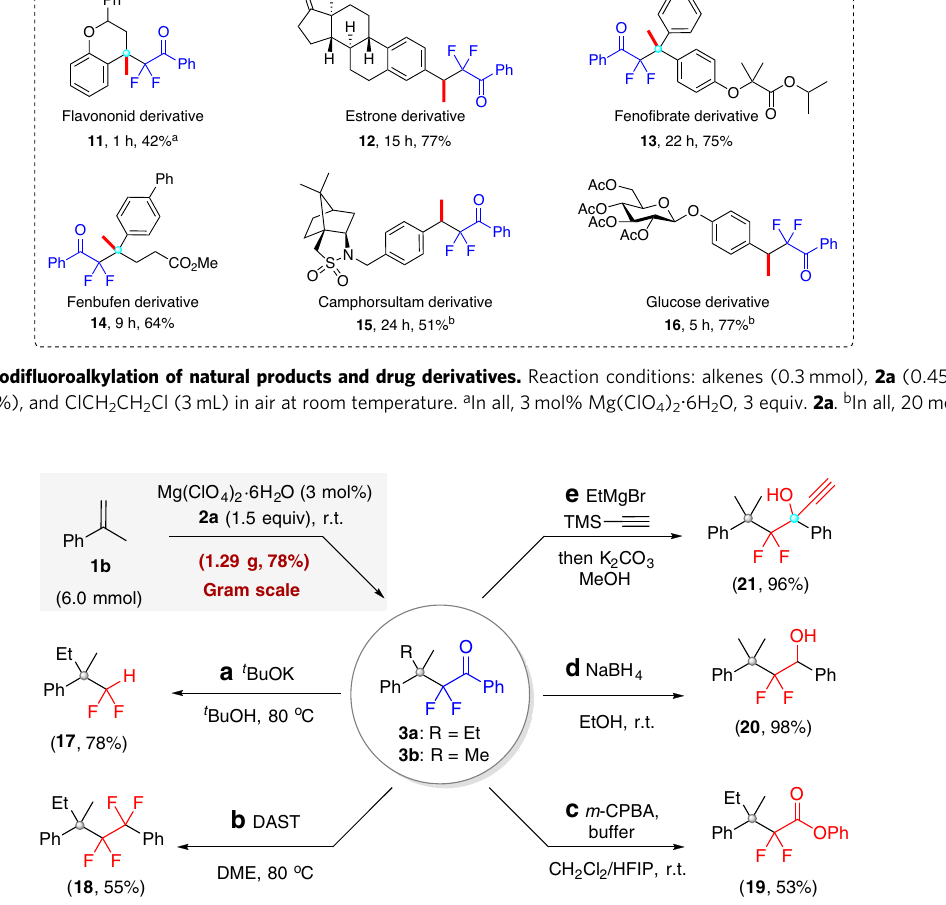
Fig. 6 Gram-scale synthesis and transformations of products. DAST diethylaminosulfur tri fl uoride, DME 1,2-dimethoxyethane, m -CPBA m -chloroperoxy- benzoic acid, HFIP 1,1,1,3,3,3-hexa fl